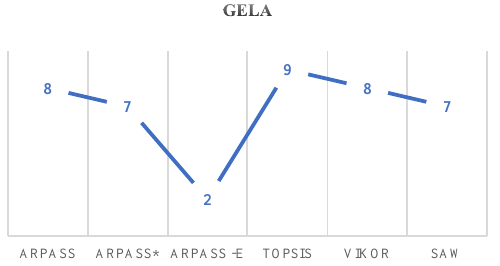
Figure 17. Rank fluctuation of Gela in the investigated MCDM methods.